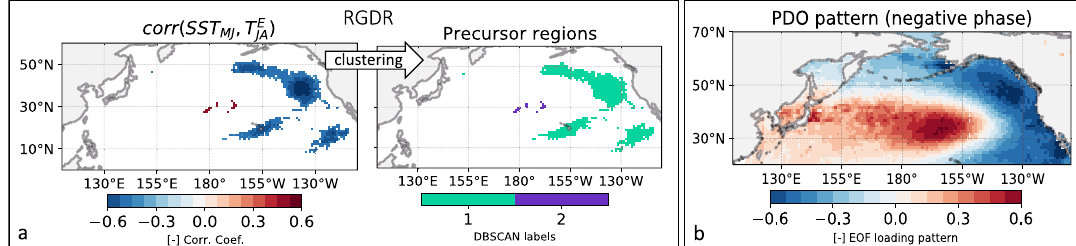
Fig. 6 Two dimensionality reduction approaches to extract precursor timeseries from the north Paci fi c SST. a Response guided dimensionality reduction (RGDR) and ( b ) (climate index) PDO timeseries. For the RGDR method, the same lag 1 (May – June SST) correlation analysis is done as shown for the TE July – August temperature in Fig. 5. For the EOF analysis, all months (Jan – Dec) are